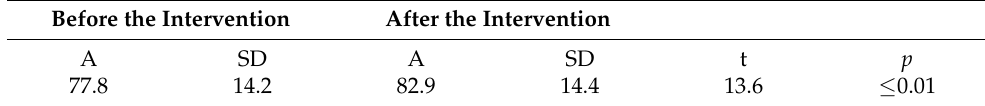
Table 2. The lifestyle of the elderly before and after the intervention